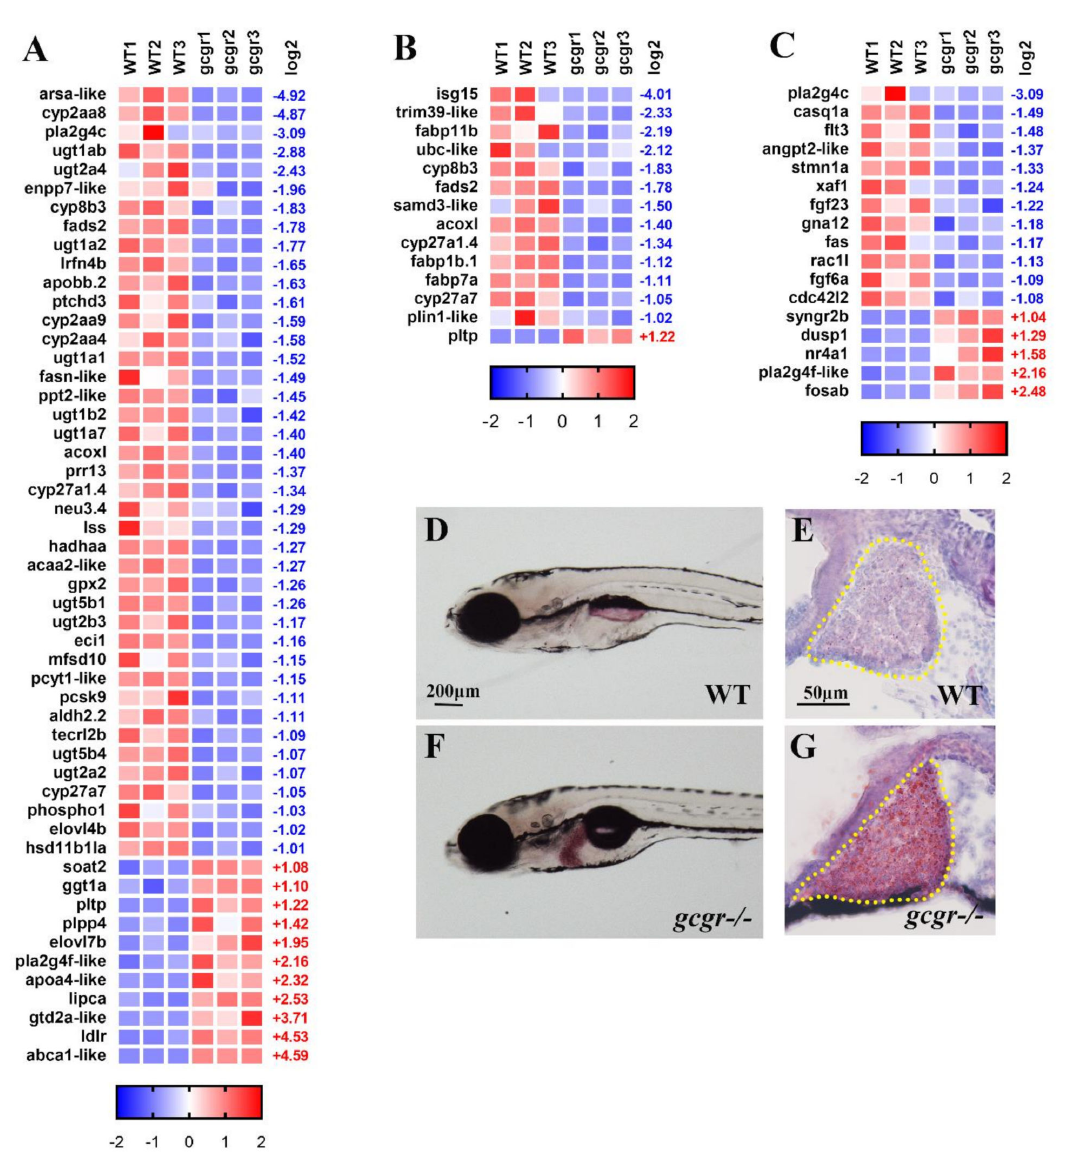
Figure 4. GCGR regulate lipid metabolism in zebrafish larva. ( A–C ) Heatmaps of transcripts in lipid metabolism enrichment ( A ) in peroxisome proliferator-activated receptors (PPAR) pathway enrichment ( B ) and in mitogen-activated protein kinase (MAPK) pathway enrichment ( C ). Colors represent high (red), low (blue), or average (white) expression values based on Z-score normalized fragments per kilo base per million mapped reads (FPKM) values for each gene. The Z-score indicators are shown under each map. The fold change (log2) are shown on the right. ( D–G ) Oil Red O (ORO) staining of 7 dpf wildtype ( F ) and gcgr − / − ( G ) mutant larvae. Whole-mount ORO staining ( D , F ) and liver frozen sections ORO staining ( E , G ) both show accumulation of lipids in the mutant liver. Yellow dash line indicates the liver